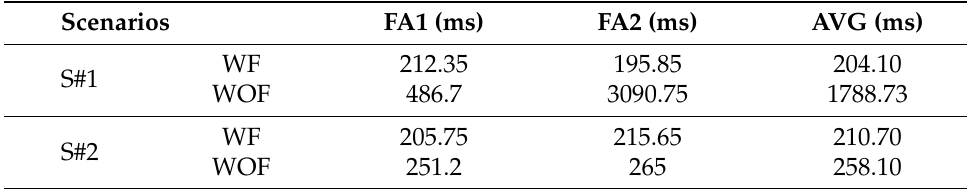
Table 5. Error resolution time measurements.